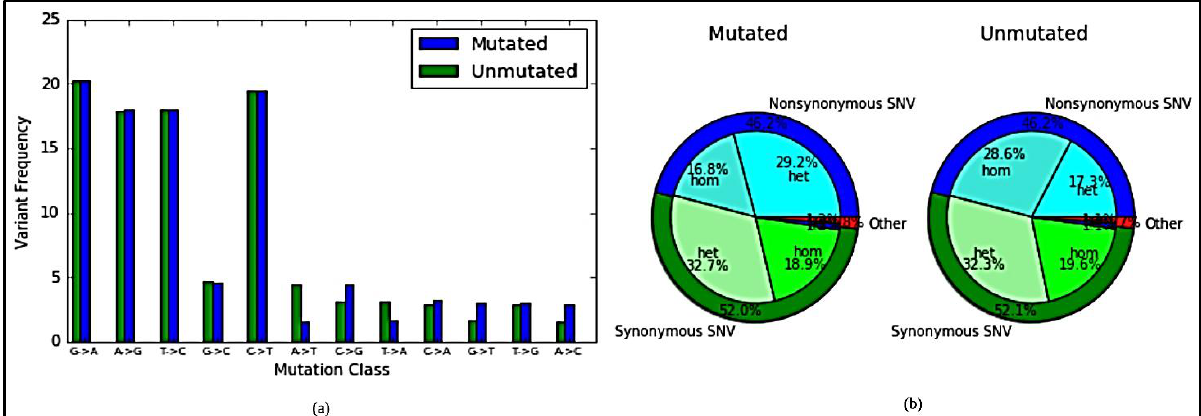
Figure 4. WES analysis result inter-person visualization: (a) frequency of transitions and transversions in the two group (b) the distribution of synonymous/non-synonymous, homozygous/heterozygous SNPs for each group.